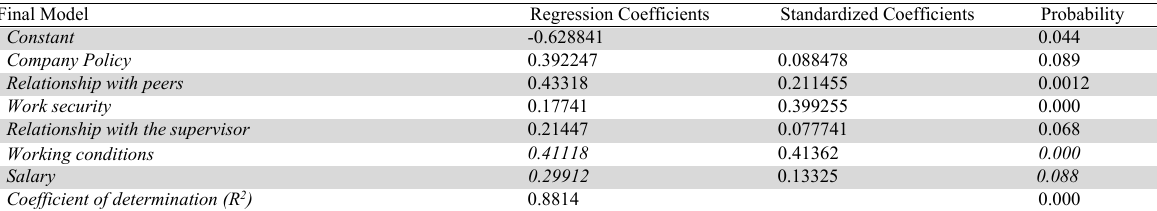
Coefficients of the final model (Continuance